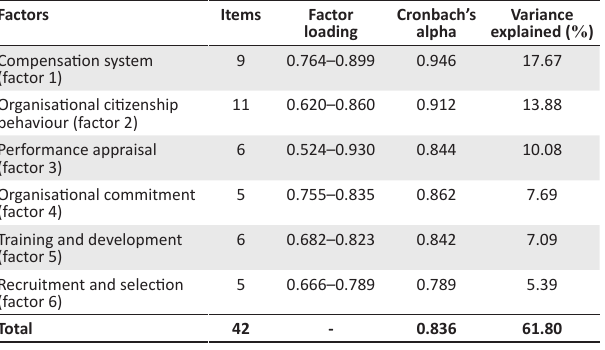
TABLE 2: Exploratory factor analysis